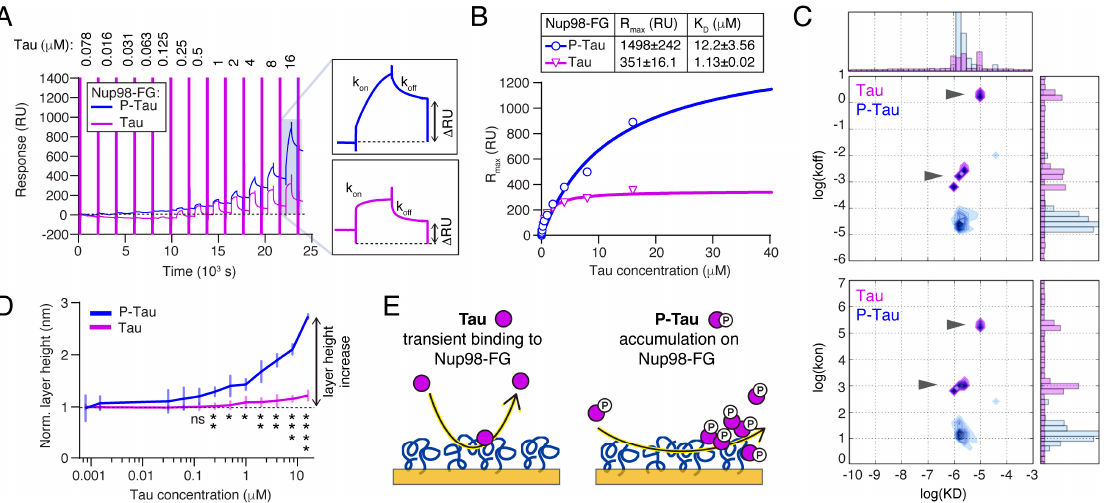
Figure 3. Phosphorylation leads to accumulation of Tau within Nup98-FG layers. ( A ) SPR response curves for Tau and P-Tau to Nup98-FG. Illustrated zoom-in highlights the difference in association and dissociation, showing slower k on and k off and a larger R max and ∆ RU for P-Tau compared to Tau. ( B ) Equilibrium fit (Langmuir binding isotherm) to RU max plotted versus Tau concentration for the binding reactions shown in ( A ). In the table, fit results are shown as the value ± SD. ( C ) Kinetic maps for Tau (purple) and P-Tau (blue) binding to Nup98-FG show log (k off ) (top) and log (k on ) (bottom) plotted versus log (K D ). Notably, two groups of k on and k off are detected for Tau (black arrow heads). ( D ) Layer height increase (derived from the differences in the BSA injection signals in the sample versus reference channels) of Tau and P-Tau shows accumulation of P-Tau on Nup98-FG layer starting at 0.25 µ M p-Tau. Data are shown as the mean + SD. Comparison of Tau and P-Tau at individual Tau concentrations with unpaired Student’s t -test, 0.25 µ M: p = 0.0077; 16 µ M: p < 0.0001 (* p < 0.05, ** p < 0.01, *** p < 0.001, **** p < 0.0001). ( E ) Model of different binding behaviors of